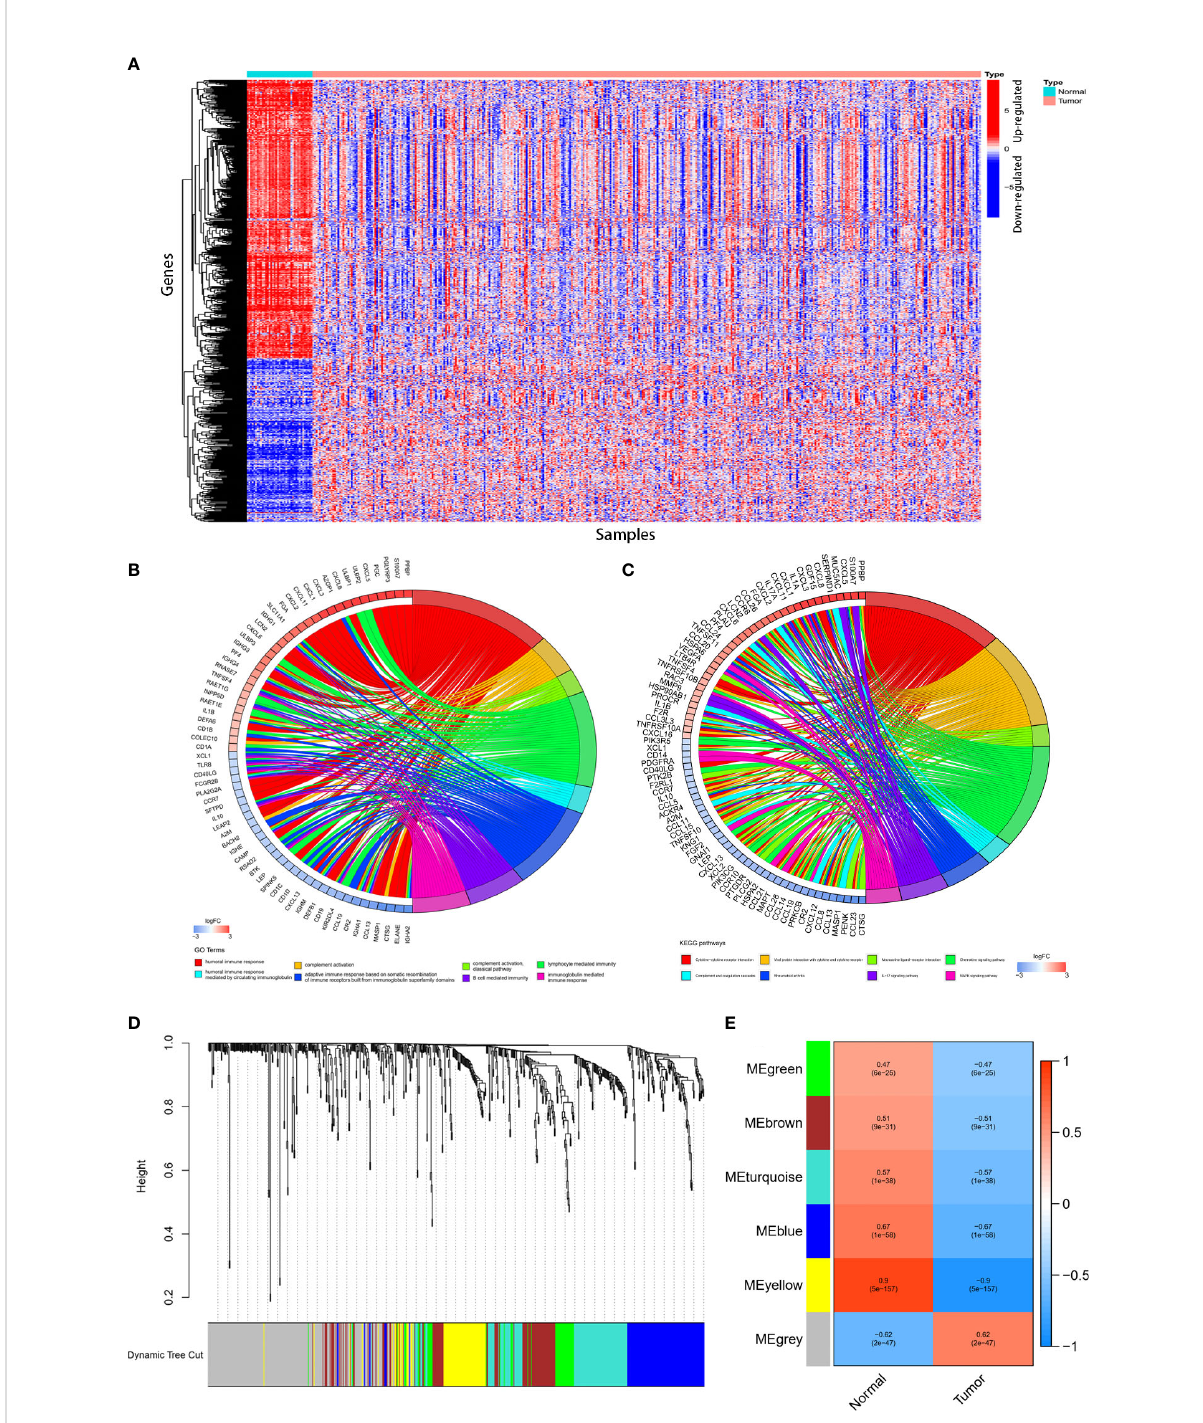
FIGURE 1 Identi fi cation of differentially expressed immune-related genes (DEIRGs) and construction of co-expression modules. 680DEIRGs were identi fi ed. (A) Heatmap of the 680 DEIRGs. The DEIRGs were enriched in GO terms (B) related with humoral immune response, complement activation, adaptive immune response, B cell mediated immunity, lymphocyte mediated immunity and immunoglobulin mediate immune response and KEGG pathways (C) related with cytokine-cytokine receptor interaction, complement and coagulation cascades, viral protein interaction with cytokine and cytokine receptor, IL-17 signaling pathway, chemokine signaling pathway, MAPK signal pathway. Six co-expression modules were constructed through WGCNA. The yellow module has the strongest correlation with colon cancer. (D) Dendrogram of the six modules. (E) Heatmap of the correlation between module eigengenes and sample